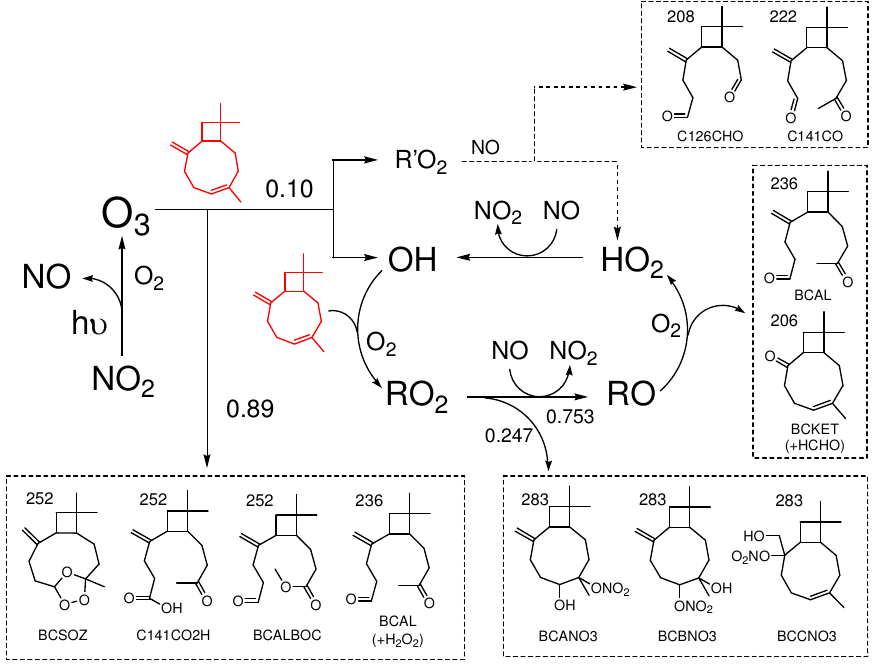
Fig. 10. Schematic of the main features of MCM v3.2 chemistry of β -caryophyllene-NO x photo-oxidation, appropriate to the early stages of the ACES experiments in the Manchester chamber. Primary removal of β -caryophyllene occurs via ozonolysis, following reagent NO 2 photolysis, with the importance of the OH-initiated chemistry amplified in the presence of NO (see discussion in text). “RO 2 ” is used to denote the collective population of BCAO2, BCBO2 and BCCO2; “RO” to denote the collective population of BCAO, BCBO and BCCO; and “R’O 2 ” to denote the collective population of BCALAO2, BCALBO2 and BCALCO2. The molecular masses of the products are also shown.